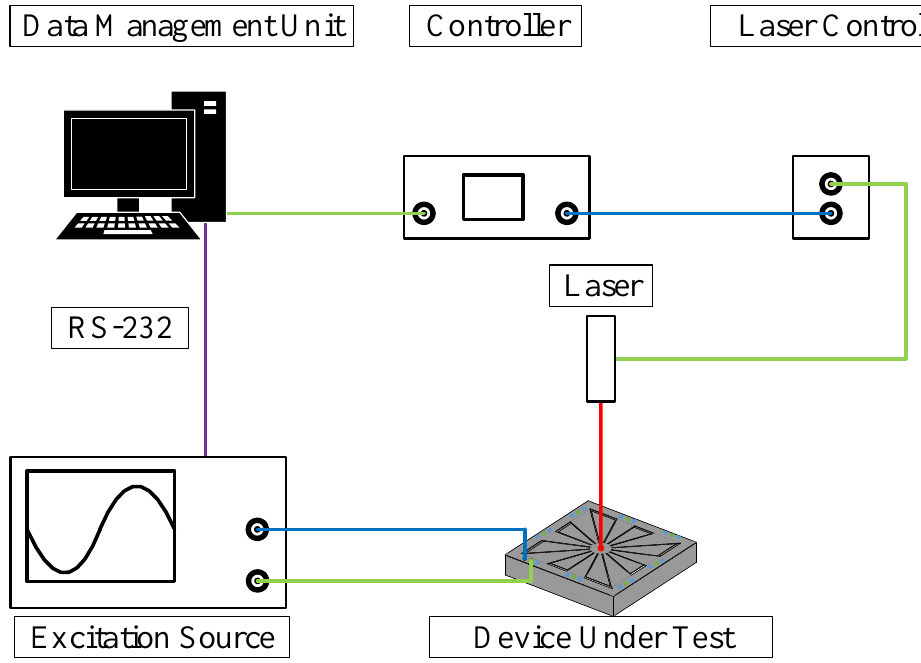
Figure 6. Schematic of the vibrometer test